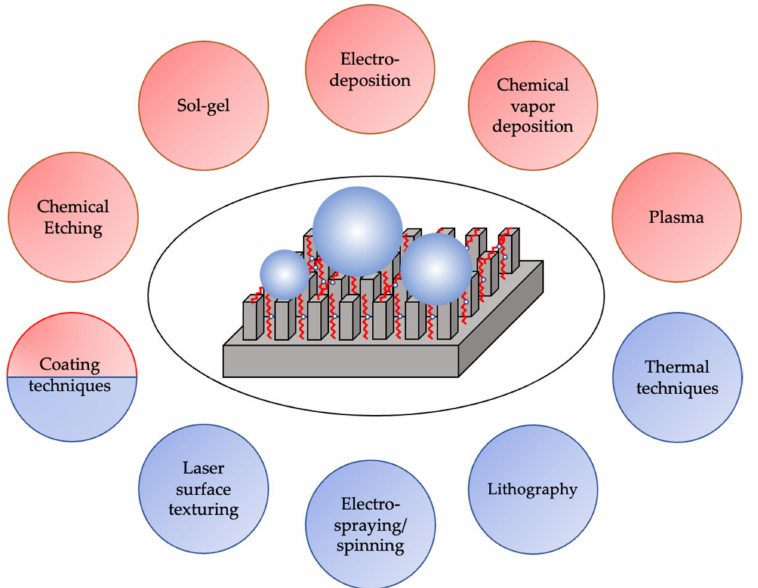
Figure 7. An overview of fabrication techniques of SH surfaces, categorized into physical (blue-color) and chemical techniques